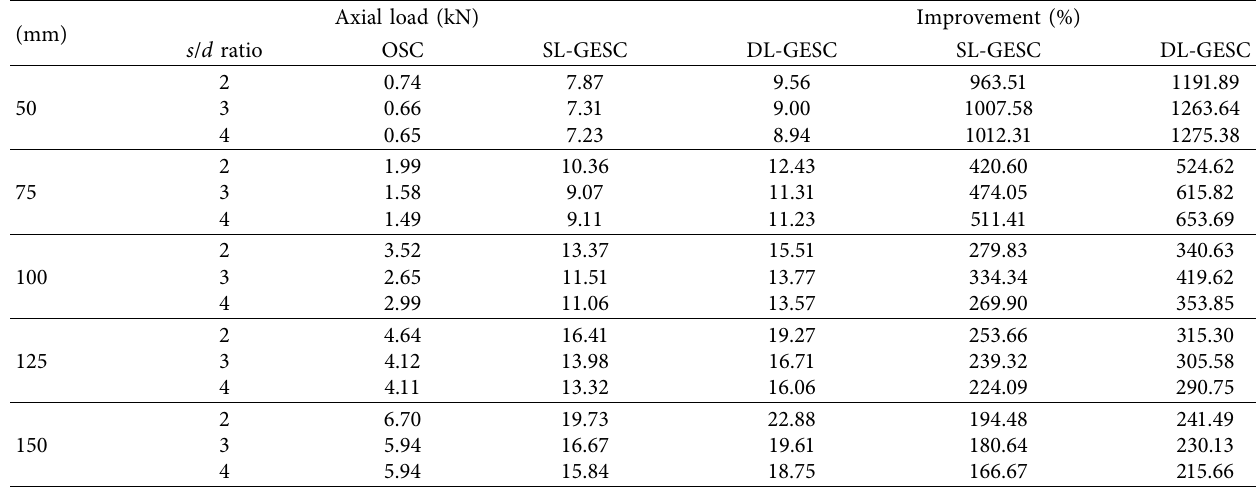
Figure 8: Efect of encasement on axial stress vs. settlement for single column of various diameter of stone column: (a) s / d � 2, (b) s / d � 3, and (c) s / d � 4. Table 5: Improvement in DL-GESC and SL-GESC compared to